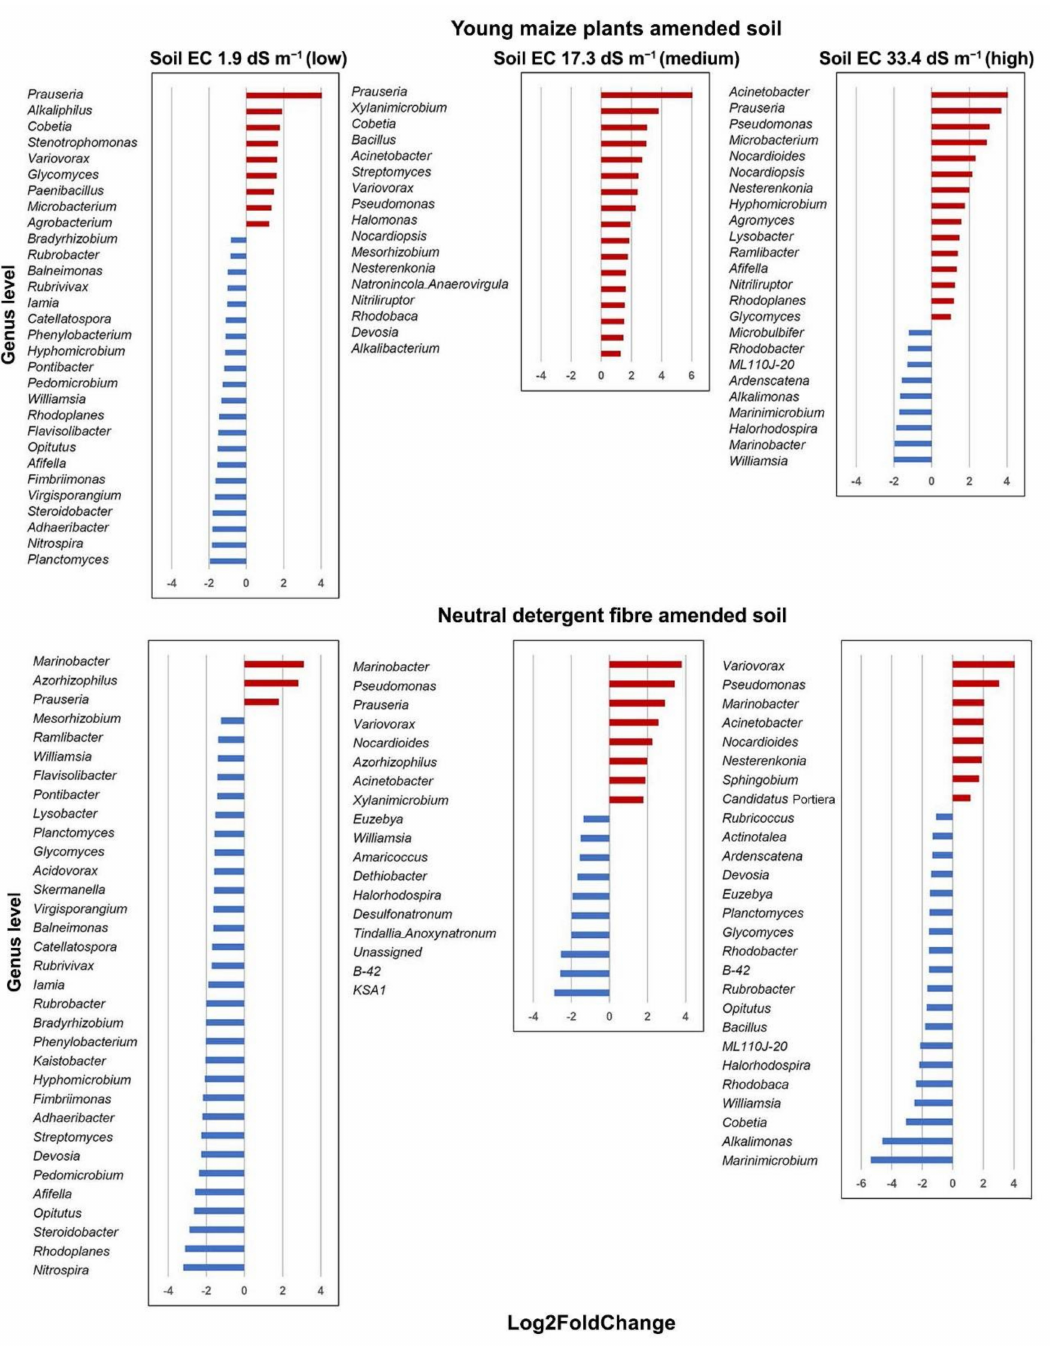
Figure 6. Differential abundance analysis with DESEq2 package [42]. A positive Log2FoldChange value (red bar) indicates a bacterial genus that was significantly enriched by the application of young maize plants or its NDF fraction, whereas a negative one (blue bar) indicates a bacterial genus that was significantly enriched in unamended control soil. Only significantly affected bacterial groups at the taxonomic level of genus are shown based on the Wald’s test ( p <